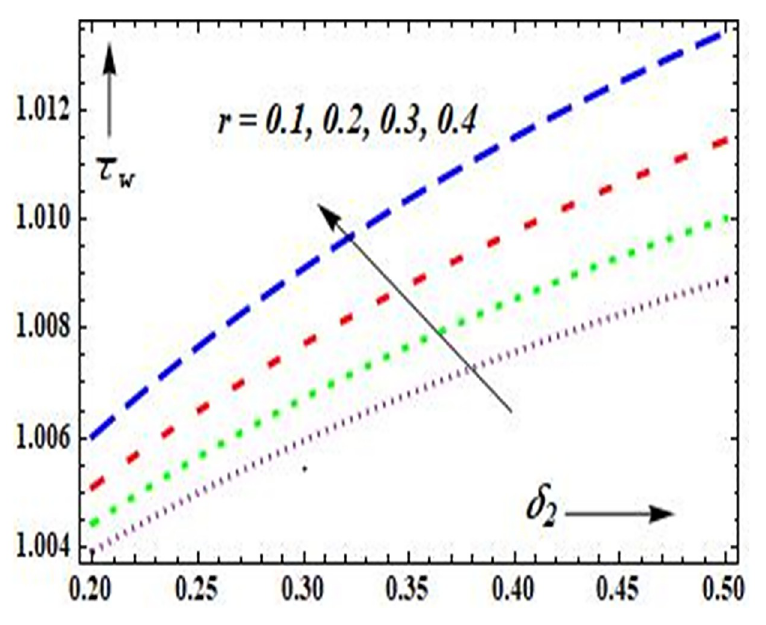
Fig 11. Plot of � τ